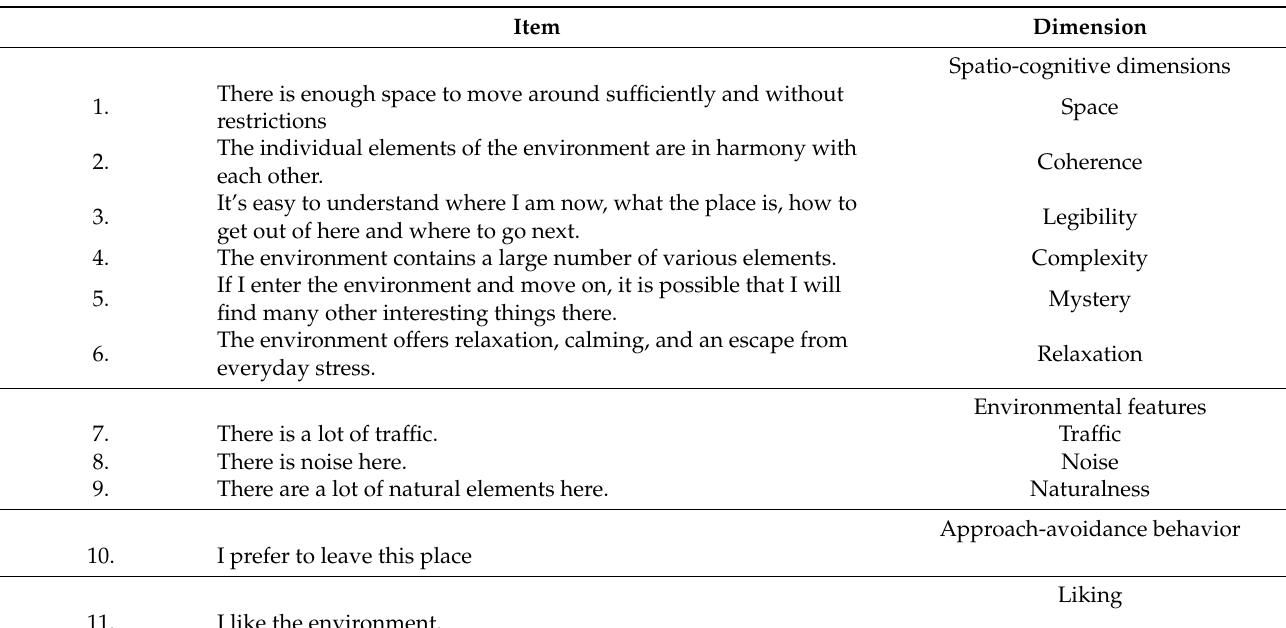
Table 2. The questionnaire used in Study